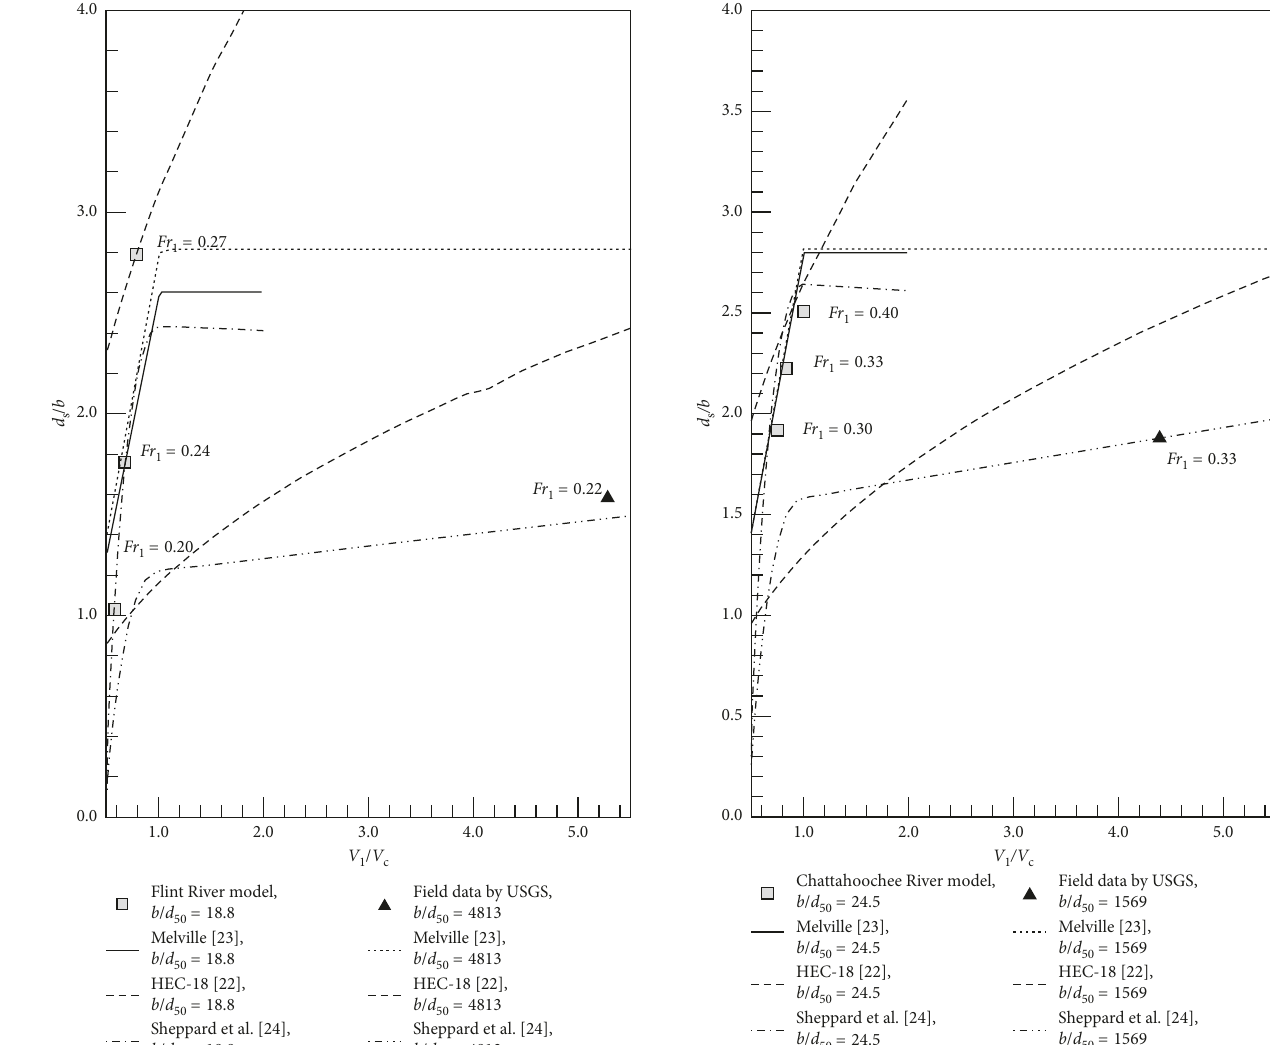
Figure 8: Comparison of field and laboratory measurements of scour depths and scour prediction formulas for Flint River Bridge.